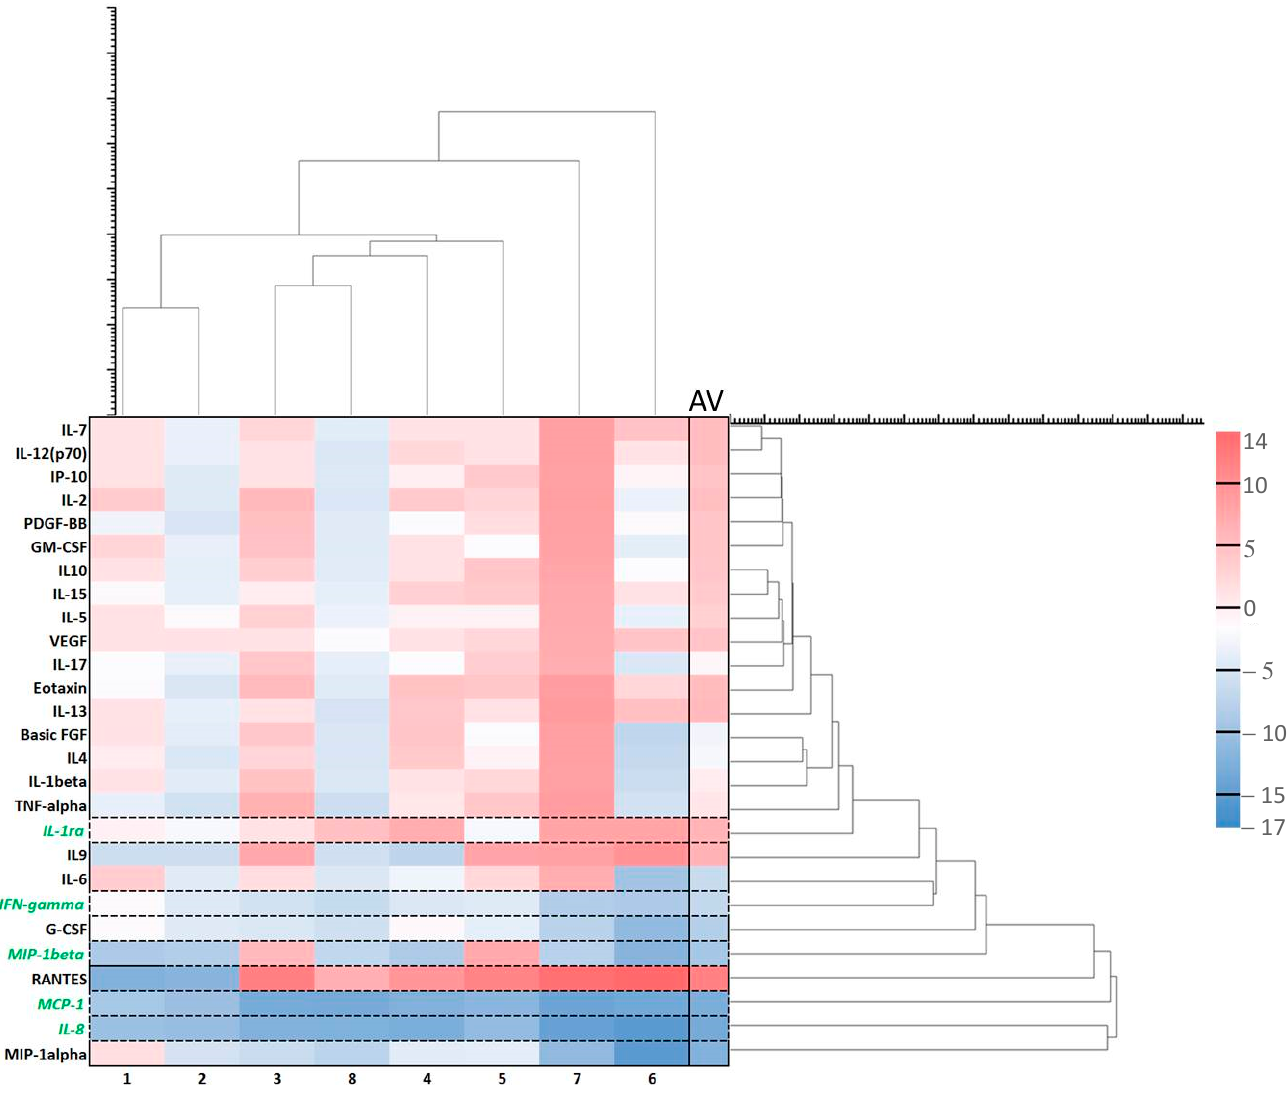
Figure 5. Effects of ALA and red light on cytokines. Cytokine heatmap with log values. Log = sgn(PDT i − ALA i )*log 2 (|PDT i − ALA i |), where PDT i is the cytokine fluorescence intensity in the group with ALA plus light and ALA i is the cytokine fluorescence intensity in the group with ALA alone. The pink colors represent increased cytokines while the blue ones show decreased cytokines after treatment with ALA plus light. The heatmap is vertically clustered by log Euclidian distances and also horizontally clustered by various patient samples. The selected cytokines with the lowest variabilities are shown with the green color. AV is an average of the log values from different samples of eight patients.